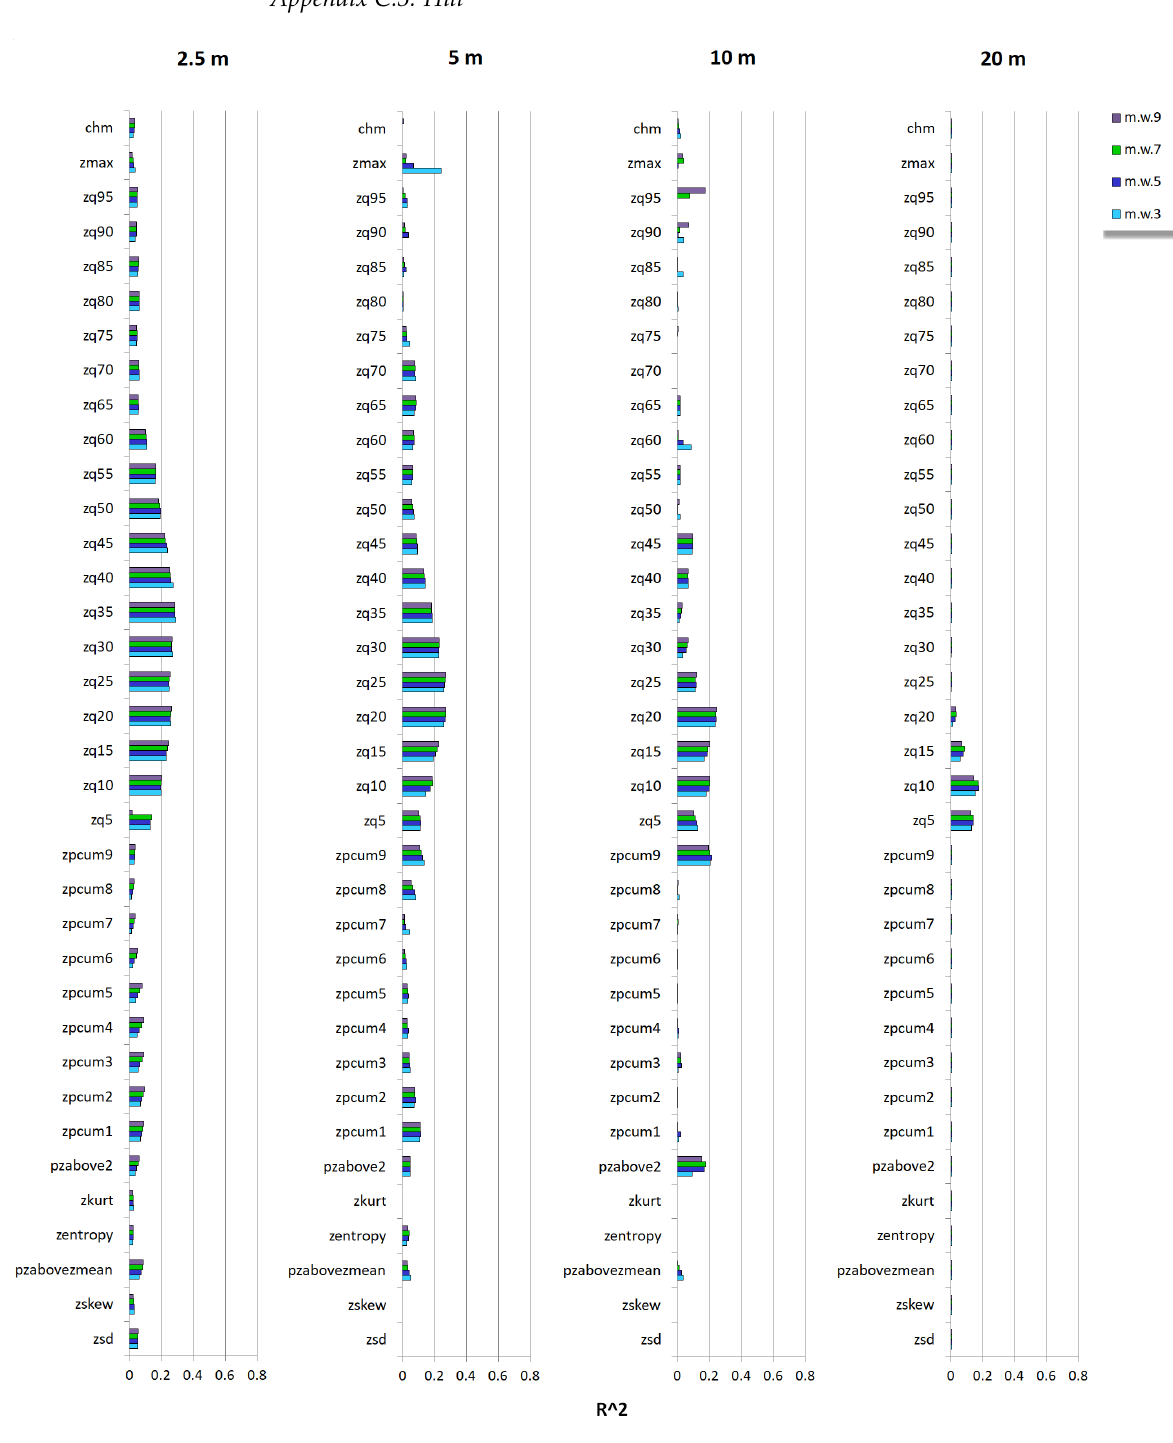
Figure A5. Histograms concerning the R 2 values relative to the linear regression between Shannon’s H field index and the mean of the Hill’s matrices of each LiDAR metric and for each MW (San Genesio/Jenesien study